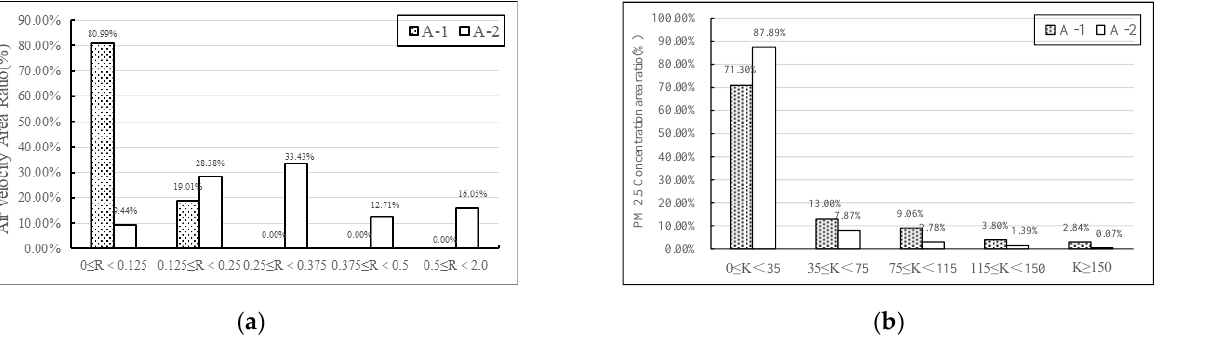
Figure 9. Column Analysis Chart: ( a ) air velocity area ratio of A-1 and A-2 kitchens. ( b ) PM2.5 concentration area ratio of A-1 and A-2 kitchens.